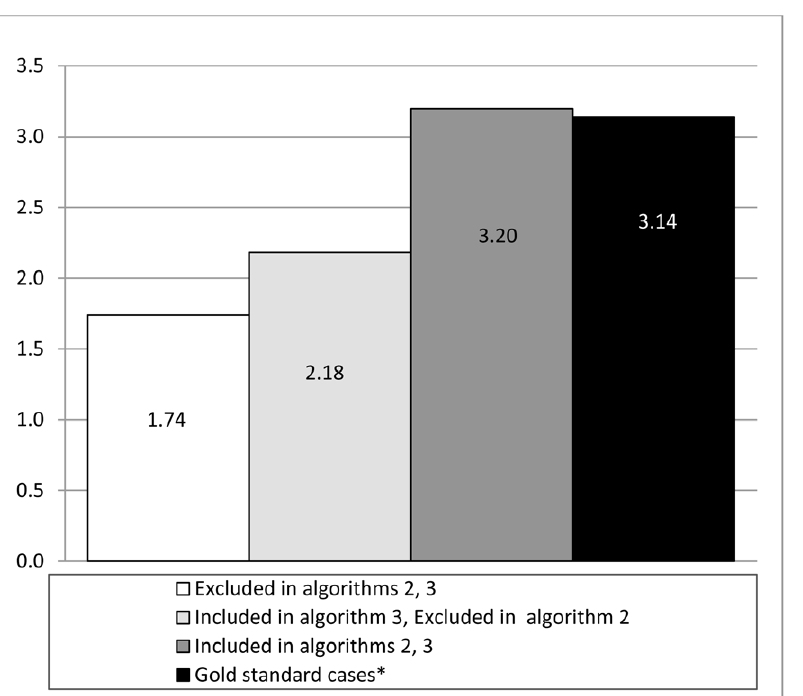
Figure 2. Mortality rates across categories of cases considered for inclusion into the STOP HIV/AIDS cohort. MoH: BC Ministry of Health; CfE: BC Centre for Excellence in HIV/AIDS; CDC: BC Centre for Disease Control. * Identified with confirmed positive HIV test, a pVL test with detectable viral load or antiretroviral dispensation.